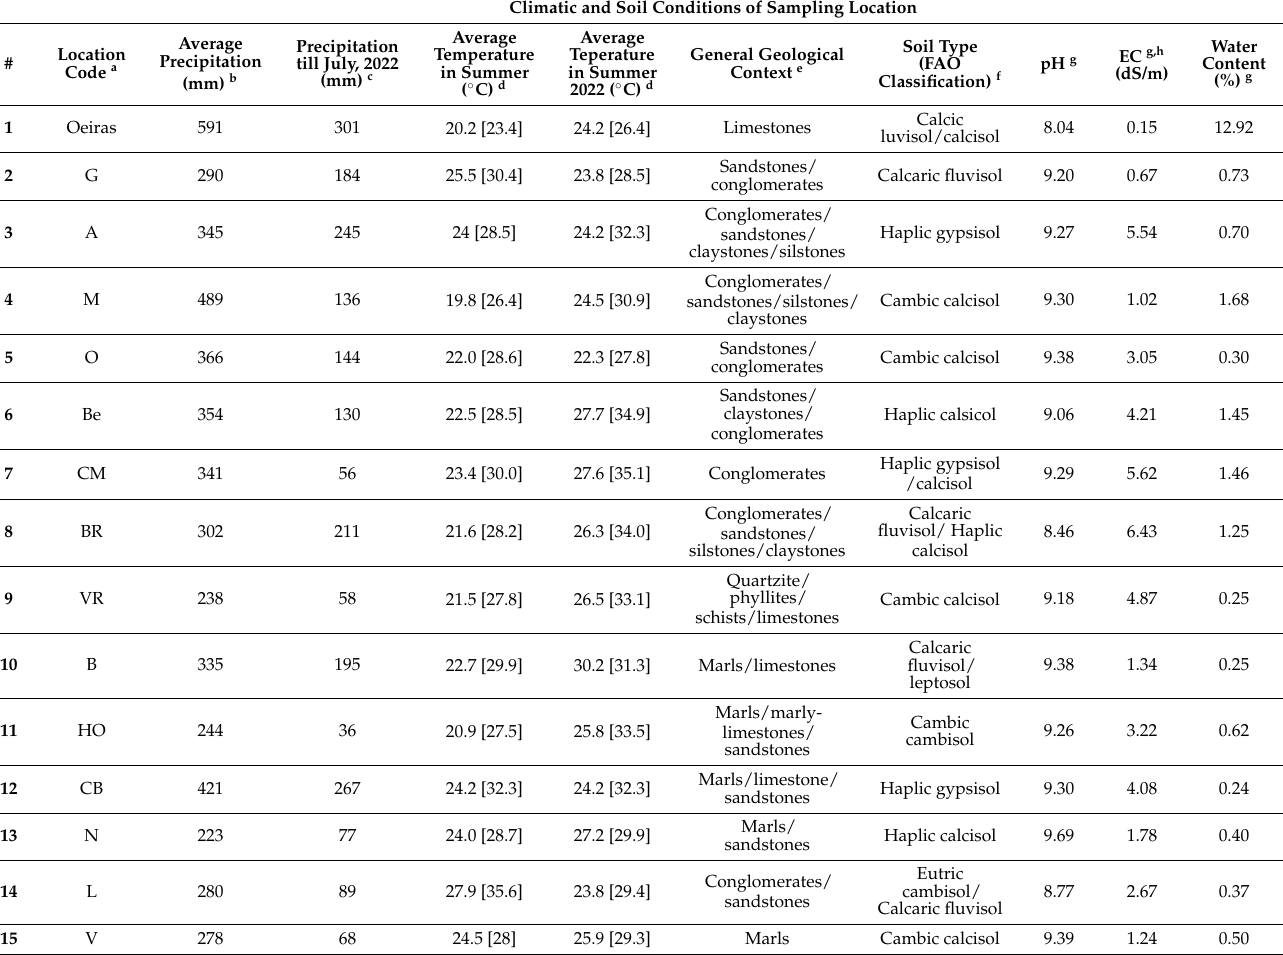
Table 2. Climatic, geologic and edaphic conditions at sampling locations. This table compiles values of climatic conditions (precipitation and temperature), geologic context and soil variables (type, pH, electro-conductivity and water content), which are factors that may condition the pres- ence/absence and diversity of plant-interacting microbiota. Climatic and Soil Conditions of Sampling